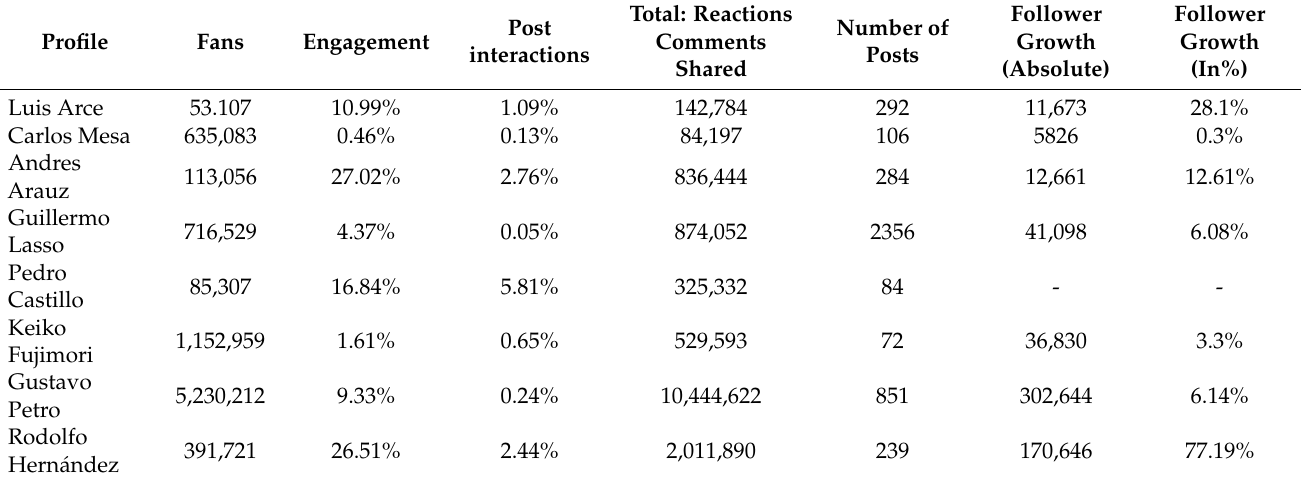
Table 3. Basic indicators of social media